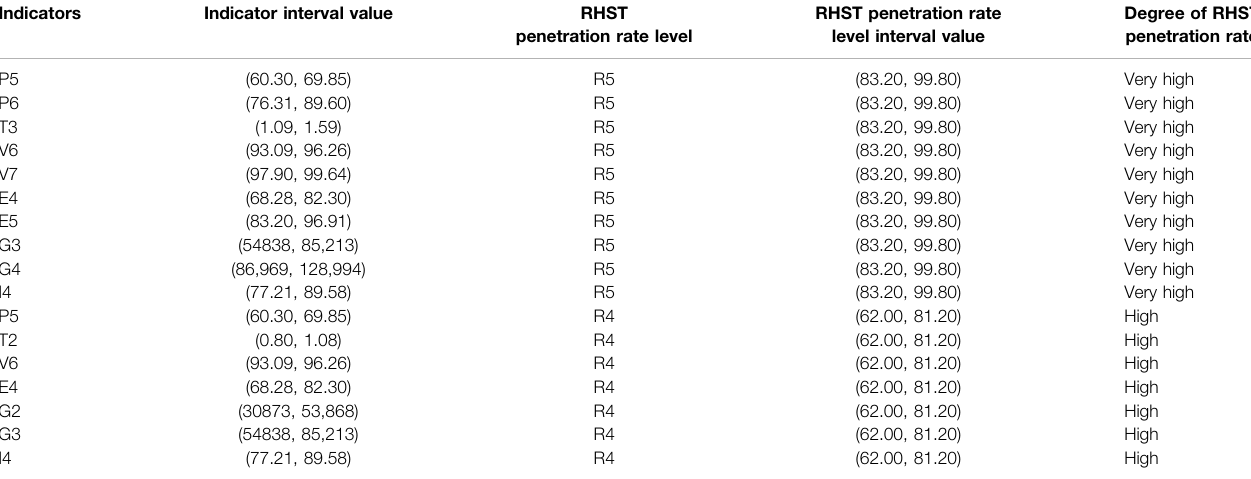
TABLE 2 | Association rules between one SED indicator and high penetration rate of RHST. Indicators